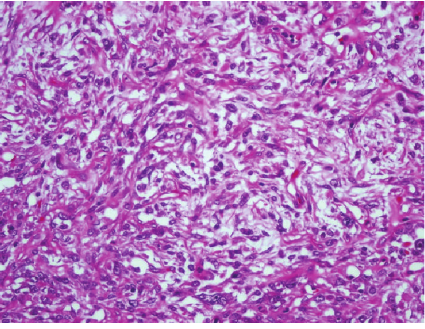
Figure 1: A serous papillary carcinoma area in the recurrent tumor: it is similar to primary ovarian tumor [HE × 400].